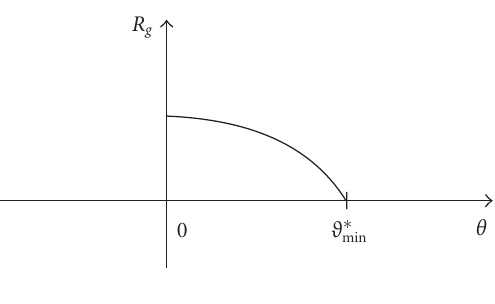
Figure 2.4. The graph of R g versus θ ( l , t